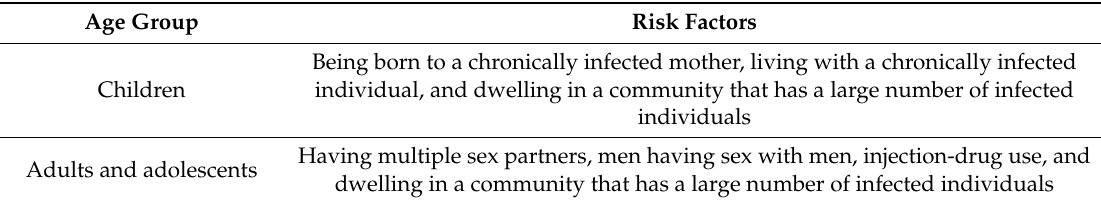
Table 3. Risk factors for elevated exposure to hepatitis